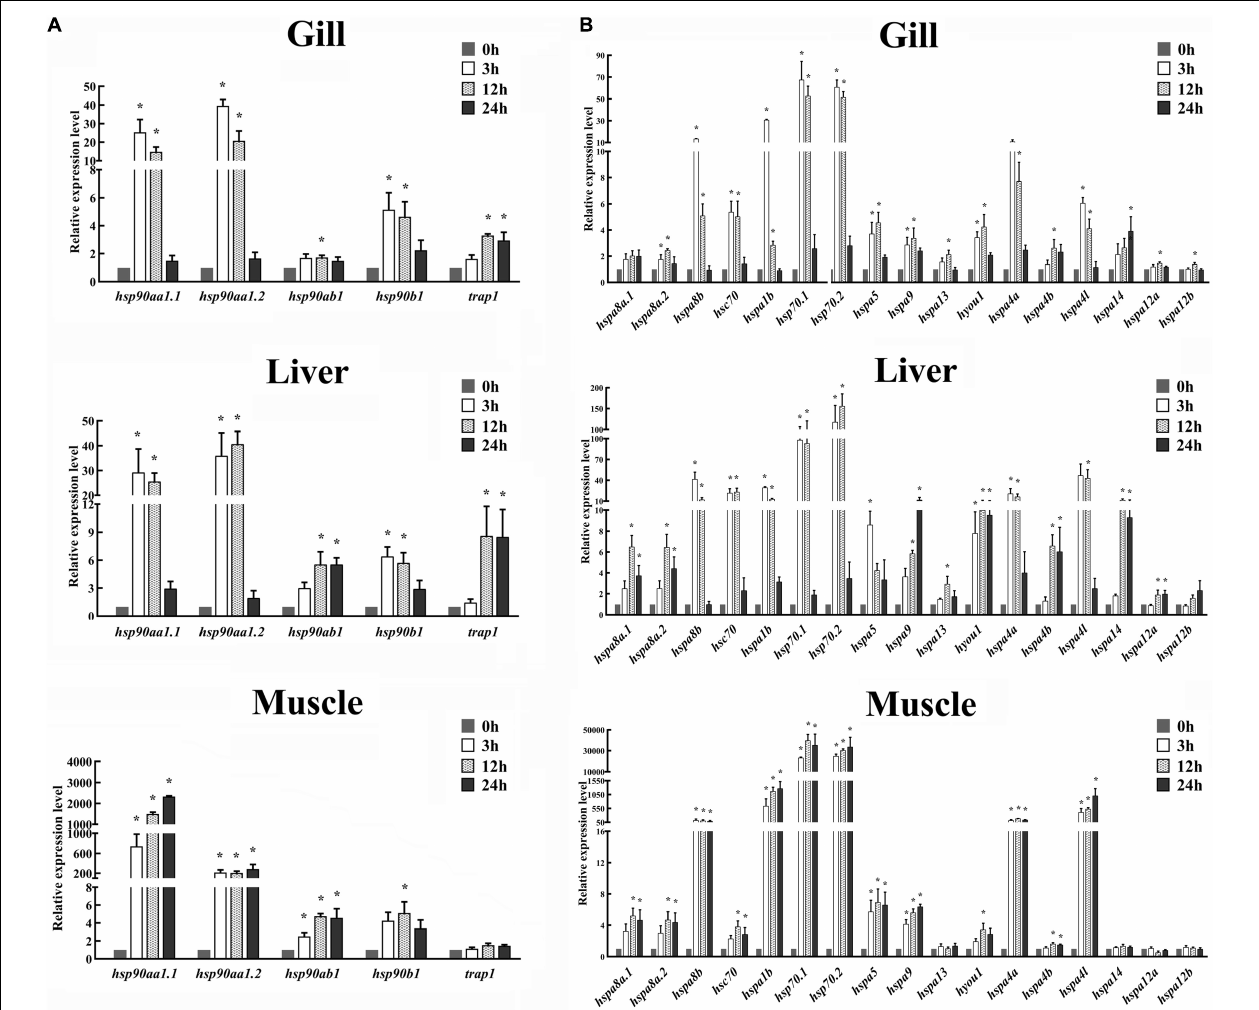
FIGURE 6 | Expression patterns of (A) HSP90 and (B) HSP70 genes in the gill, liver, and muscle of spotted seabass at 0, 3, 12, and 24 h after heat stress. The mRNA expression levels were determined by qPCR analysis. 18S rRNA was used as an internal control. Gene expressions were presented as mean ± SE. Asterisk (*) represented the significant differences ( P < 0.05). HSP, heat shock